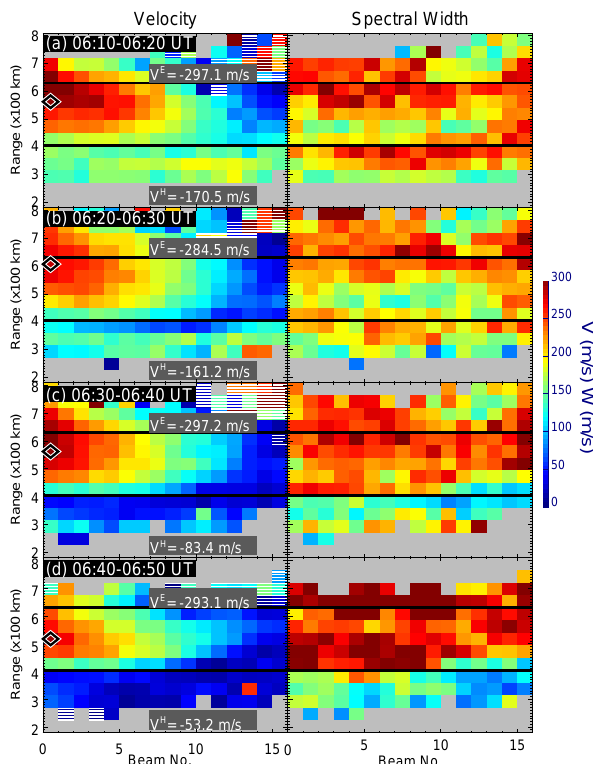
Fig. 9. Range versus beam plots for 4 selected 10-min frames (rows) on 14 April 2006 for the Bruny Island radar. The plots display the 10-min-averaged Doppler velocity (first column) and spectral width (second column) as specified on the right of the figure. The plot cells filled with solid colour (horizontal lines) correspond to the negative (positive) Doppler velocity. The horizontal black lines in- dicate the ranges of 405km and 630km. The diamonds on the left show the range-beam cell with maximum velocity detected between these ranges. The maximum velocity value V E is displayed in each plot along with the mean maximum velocity at near ranges V H (see text for